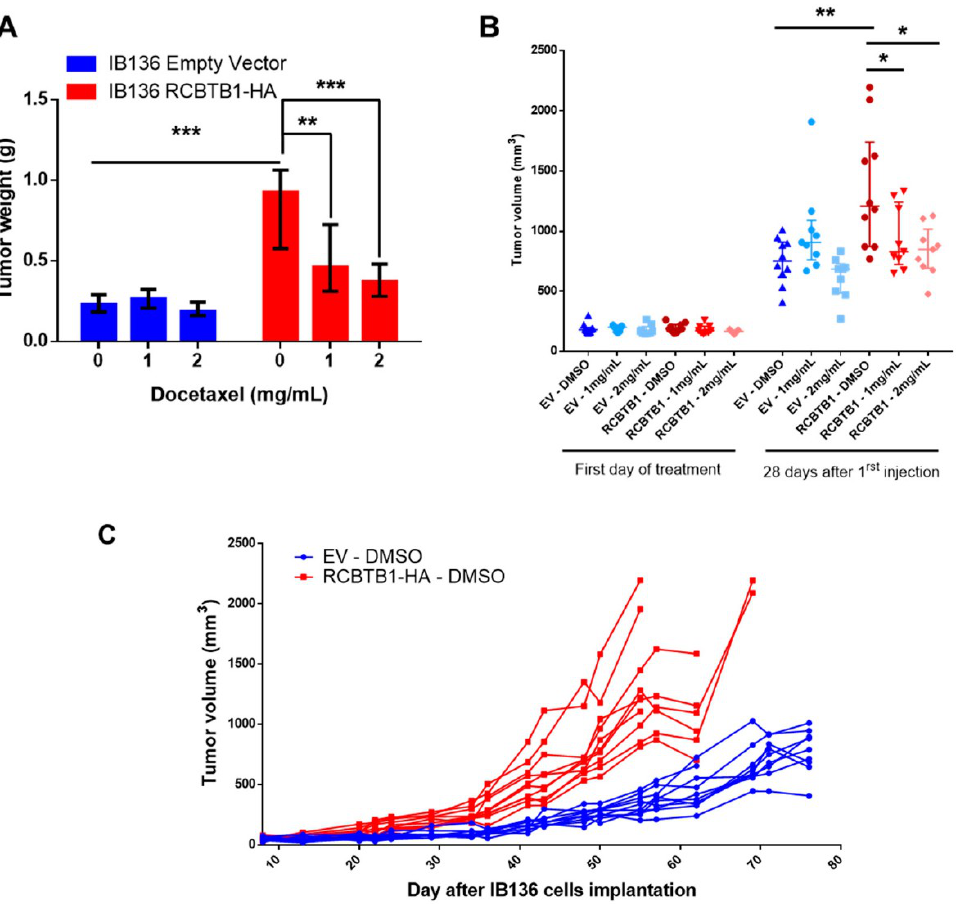
Figure 4. RCBTB1 overexpression increases tumor sensitivity to docetaxel, but also promotes tumor growth in mice. ( A ) Tumor weight after 28 days treatment (0: DMSO; 1: 1 mg/mL of docetaxel and 2: 2 mg/mL of docetaxel). Each group was composed of 10 mice. Histograms sum up results with median and interquartile range (IQR). ( B ) Tumor volume at the beginning and at the end of treatment with DMSO or docetaxel (1 mg/mL and 2 mg/mL) in each group (EV = tumors produced by IB136 empty vector cells; RCBTB1 = tumors formed by IB136 RCBTB1-HA cells). Line in the middle is the median, errors bars represent IQR. Individual points represent the volume of one tumor. ( C ) Follow-up of individual tumor volume in groups treated with DMSO since the day of cell implantation (IB136 empty vector cells in blue, IB136 RCBTB1-HA in red) until sacrifice. * p < 0.05, ** p < 0.01, *** p < 0.001.